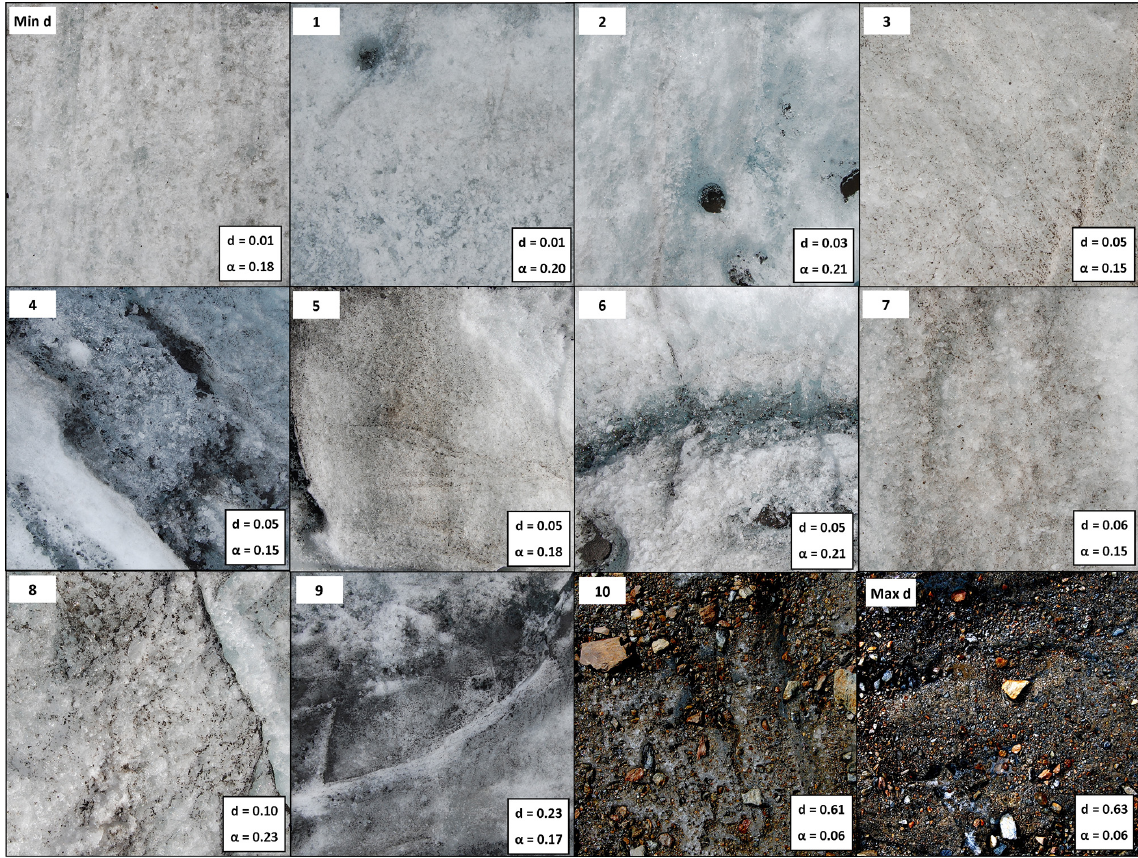
Figure 4. Examples of Forni Glacier surfaces; debris cover ratio ( d ) and measured albedo ( α ) values are shown. The first and last images show the minimum and maximum d values. Images 1–10 are used for further sensitivity tests (see Sect.